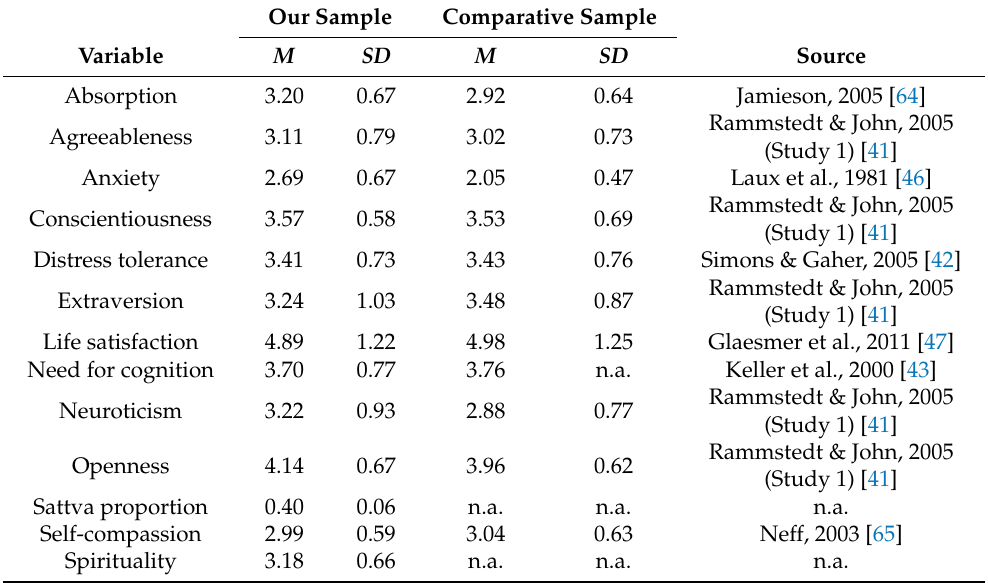
Table 1. Baseline and comparative values (if available) for all personality traits. Our Sample Comparative